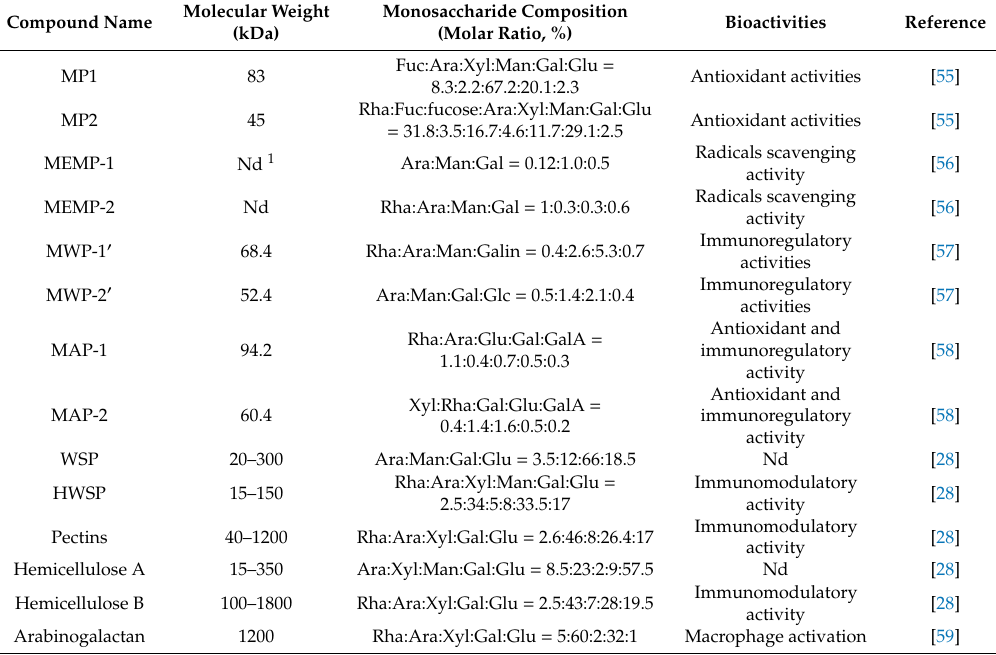
Table 2. Polysaccharides isolated from the mung bean and their